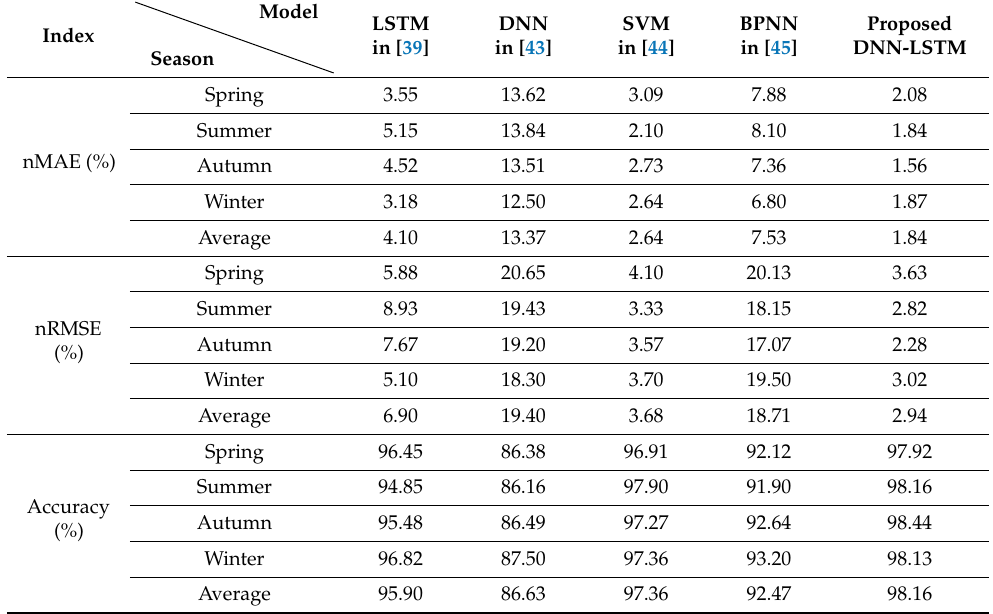
Table 6. Comparisons of performance indicators of five forecasting models for solar power plant